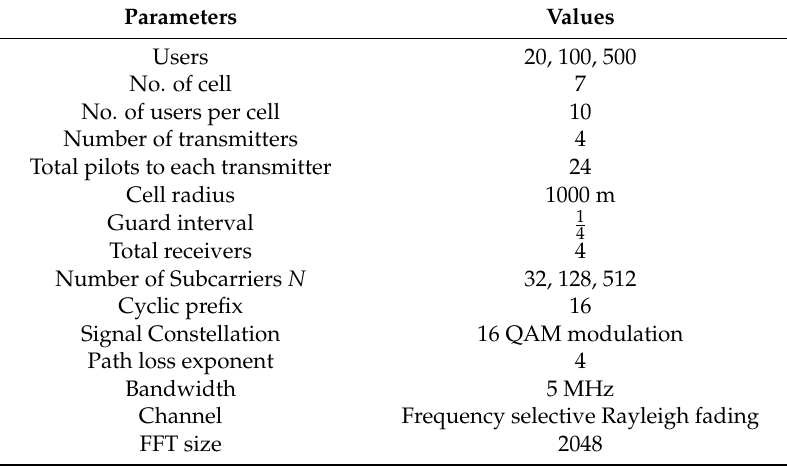
Table 2. Simulation